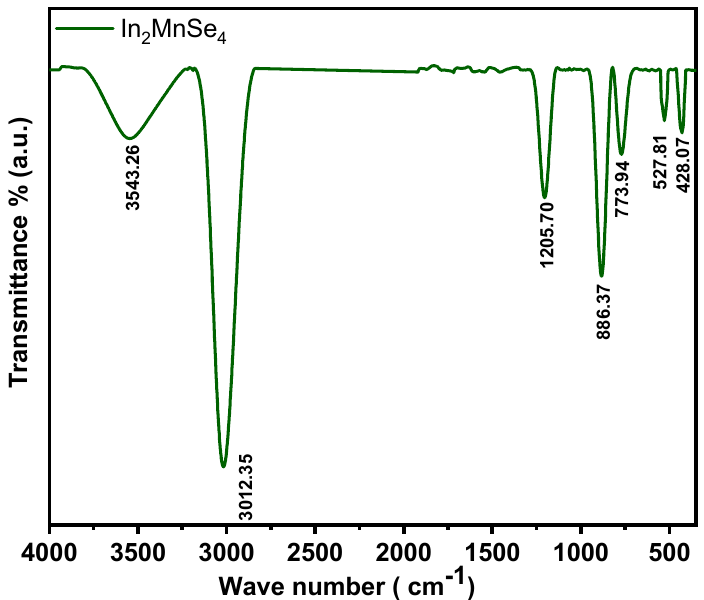
Figure 2. FTIR analysis of In 2 MnSe 4 nanostructure.